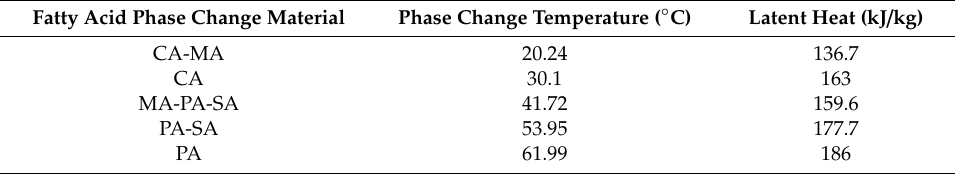
Table 3. Thermal properties of CA-MA, CA, MA-PA-SA, PA-SA, and